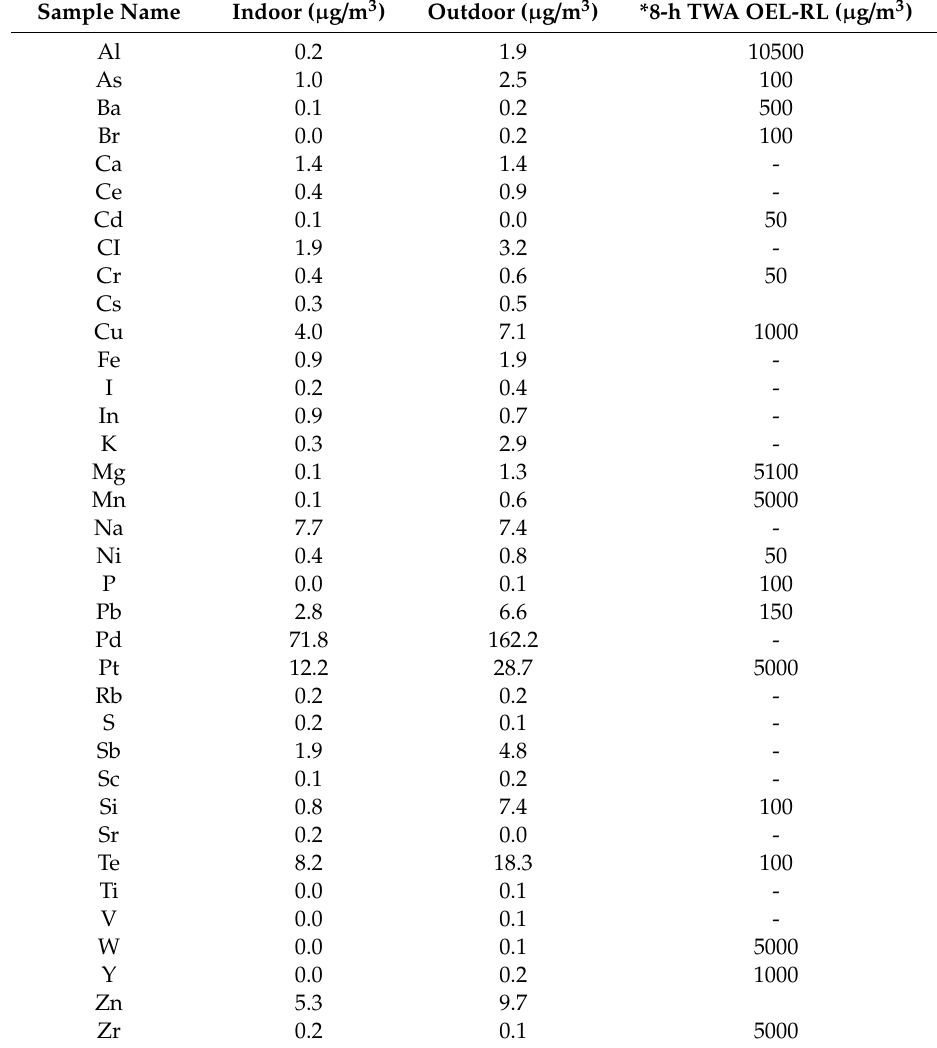
Table 4. Metal levels of indoor and outdoor PM 2.5 filter